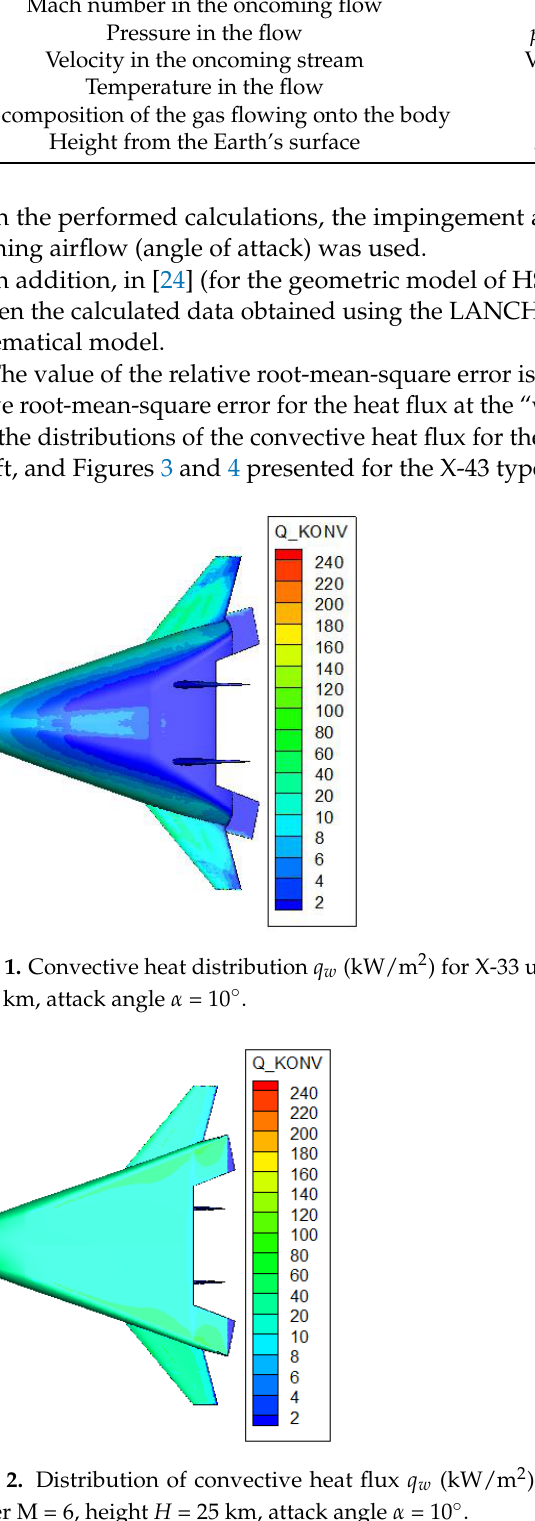
Figure 3. Convective flux w q (kW/m 2 ) distribution for X-33 upper part, Mach number M = 6, height H = 25 km, attack angle  = 10°. Figure 4. Distribution of convective heat flux w q (kW/m 2 ) for the lower part of the X-43, Mach number M = 6, height H = 25 km, attack angle  = 10°.